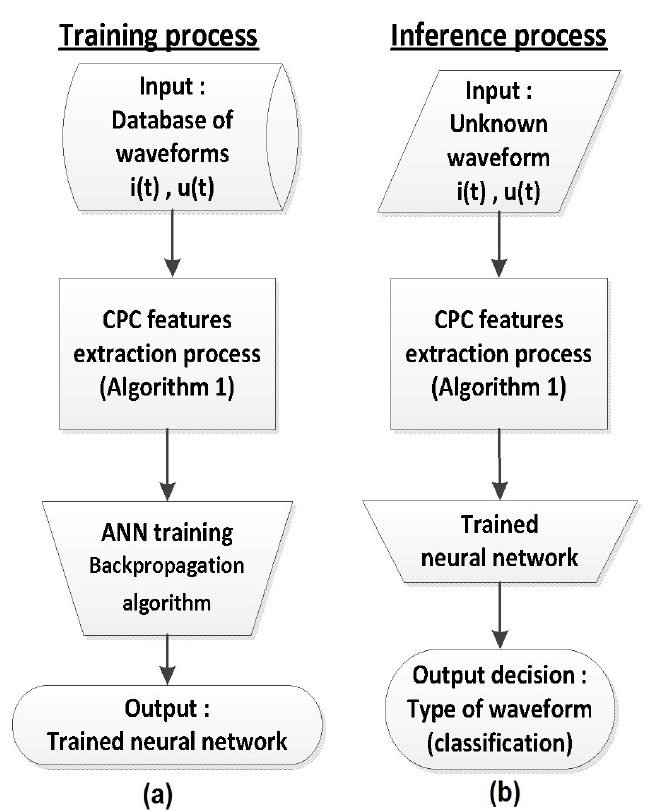
Figure 3. ( a ) Training process for creating a network of CPC features; and ( b ) inference process for unknown machine/device.